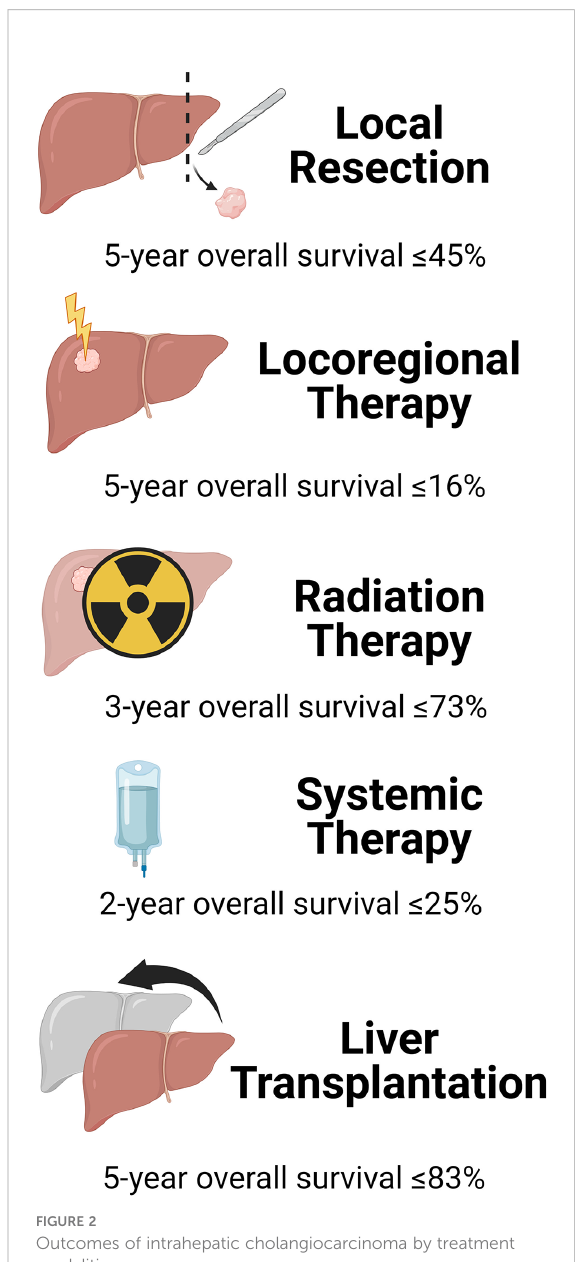
FIGURE 2 Outcomes of intrahepatic cholangiocarcinoma by treatment